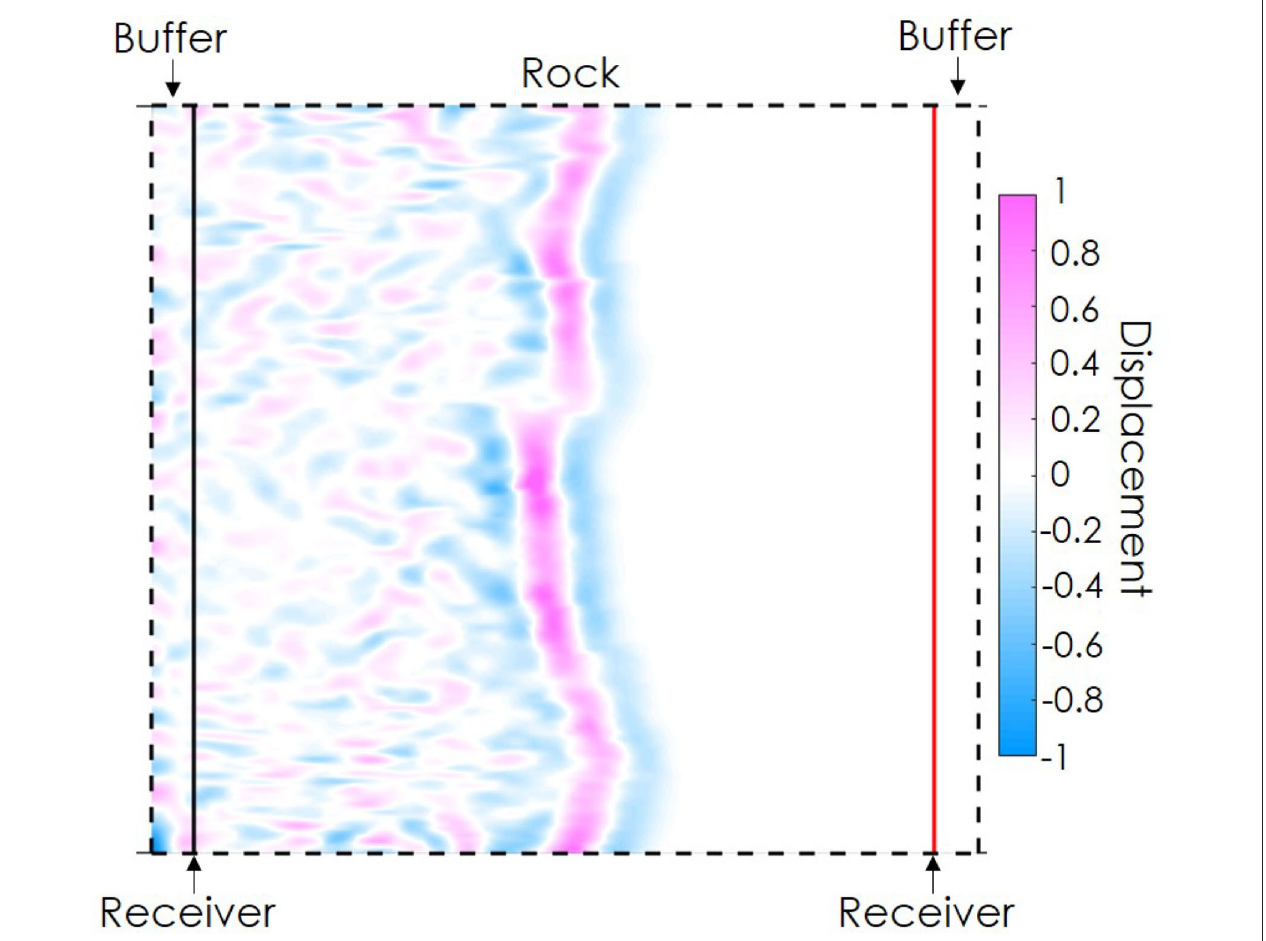
FIGURE 2 | EWAVE model component: EBSD data (“Rock”) is placed between two buffers. A Ricker wave (pink and blue) is propagated from left to right of the model. Two receivers (left: black line, right: red line) are used to record the wave signal and calculate wave travel times. Displacement is dimensionless and does not affect the